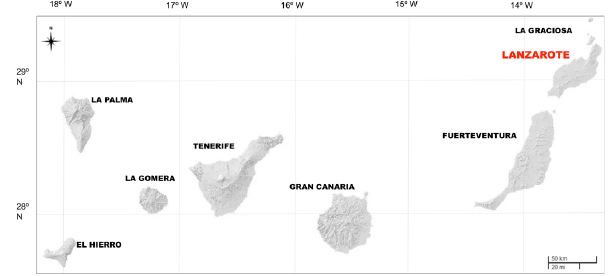
Fig. 3. Geographical setting of the Canary Islands.